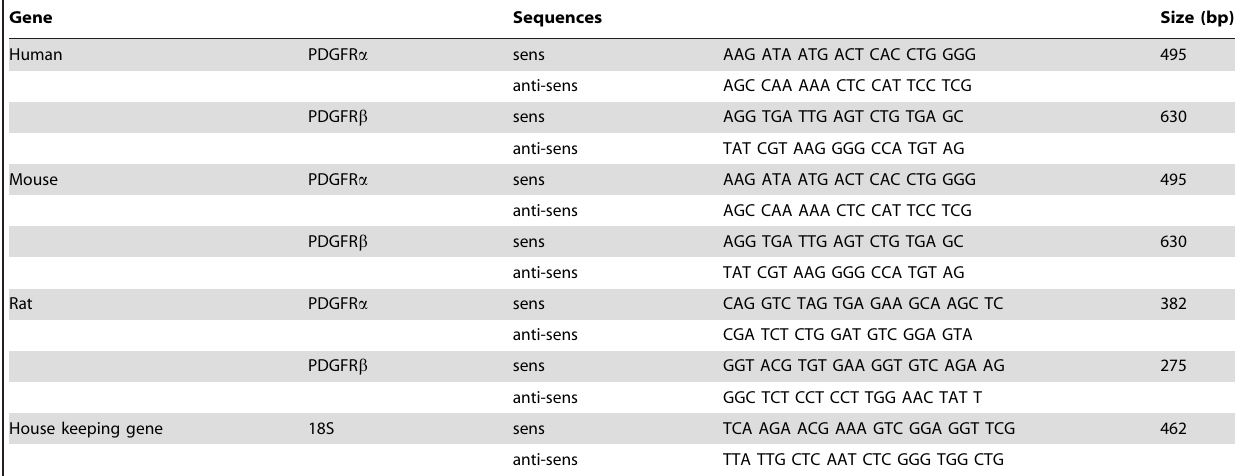
Table 2. Primer sequences for RT-PCR experiments.